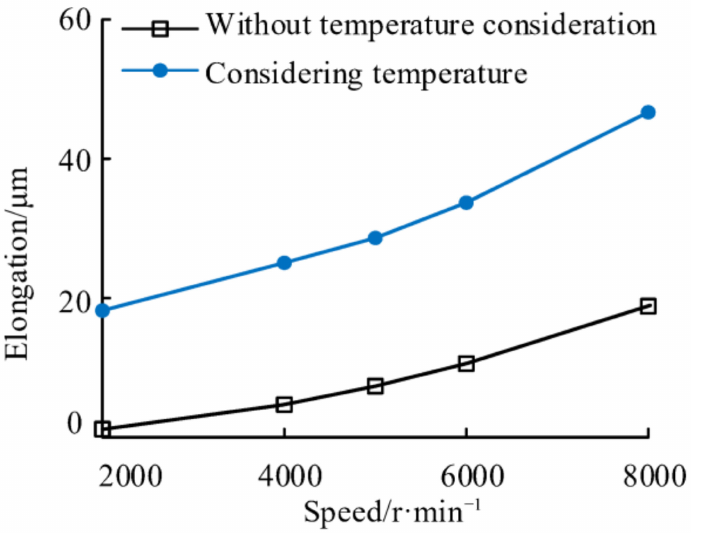
Figure 12. Elongations of NPR spacer at different